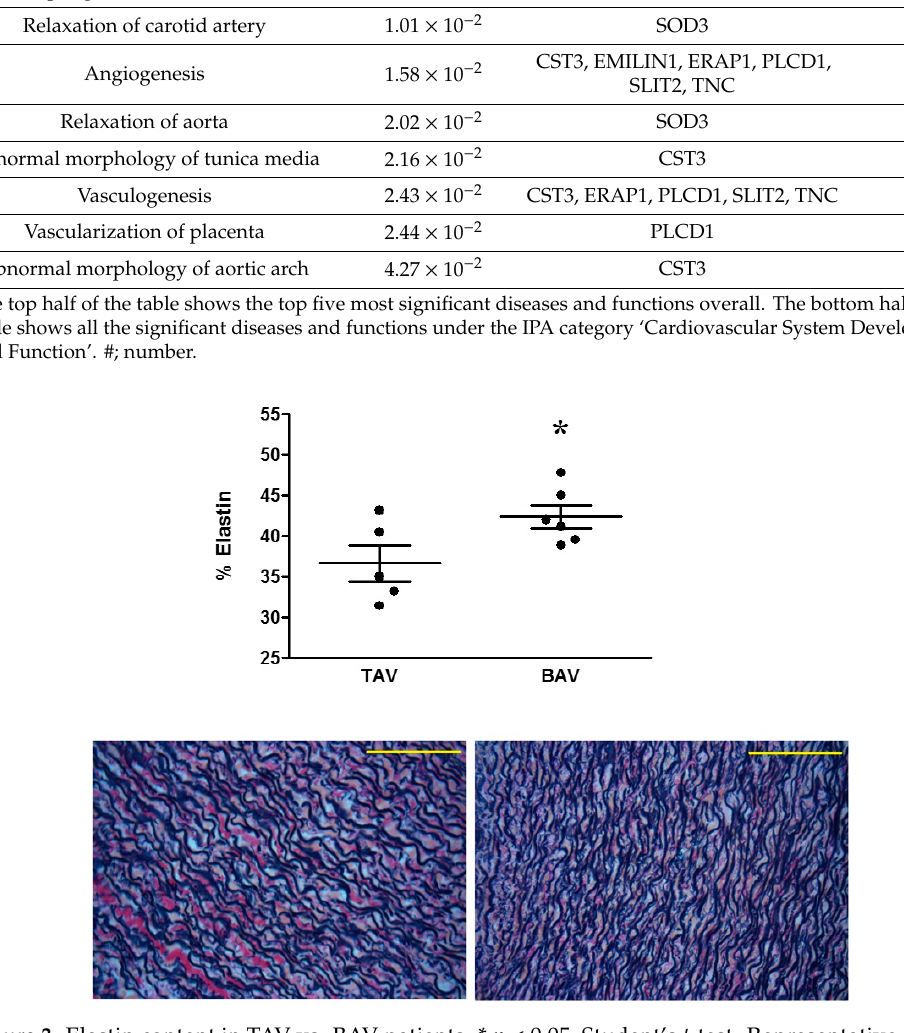
Figure 3. Elastin content in TAV vs. BAV patients. * p < 0.05, Student’s t -test. Representative elastin staining from TAV ( left ) and BAV ( right ) patients. Scale bars represent 40 µm. A total of 75 phosphorylated proteins were identified, some with multiple phosphorylation sites, resulting in 90 phosphorylation site matches. Only one, protein phosphatase slingshot homolog 3, was differentially expressed between BAV patients and TAV patients (Table 4), resulting in significant enrichment in a number of pathways involved in inositol metabolism (Table 5).